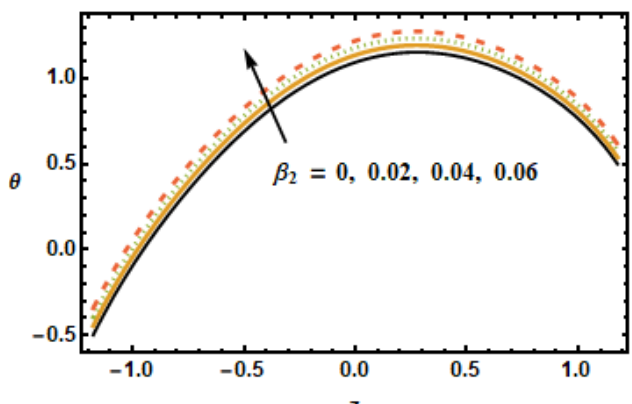
θ on permeability 1 θ on permeability 1